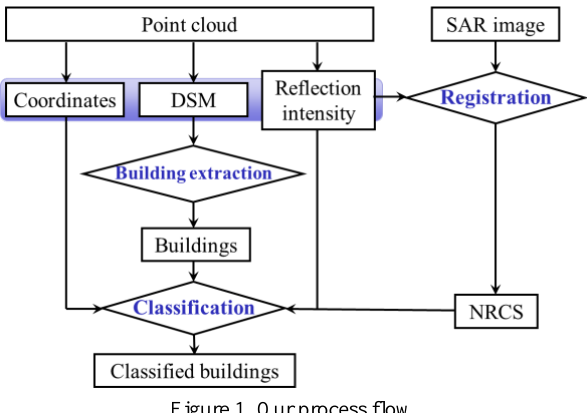
Figure 1. Our process